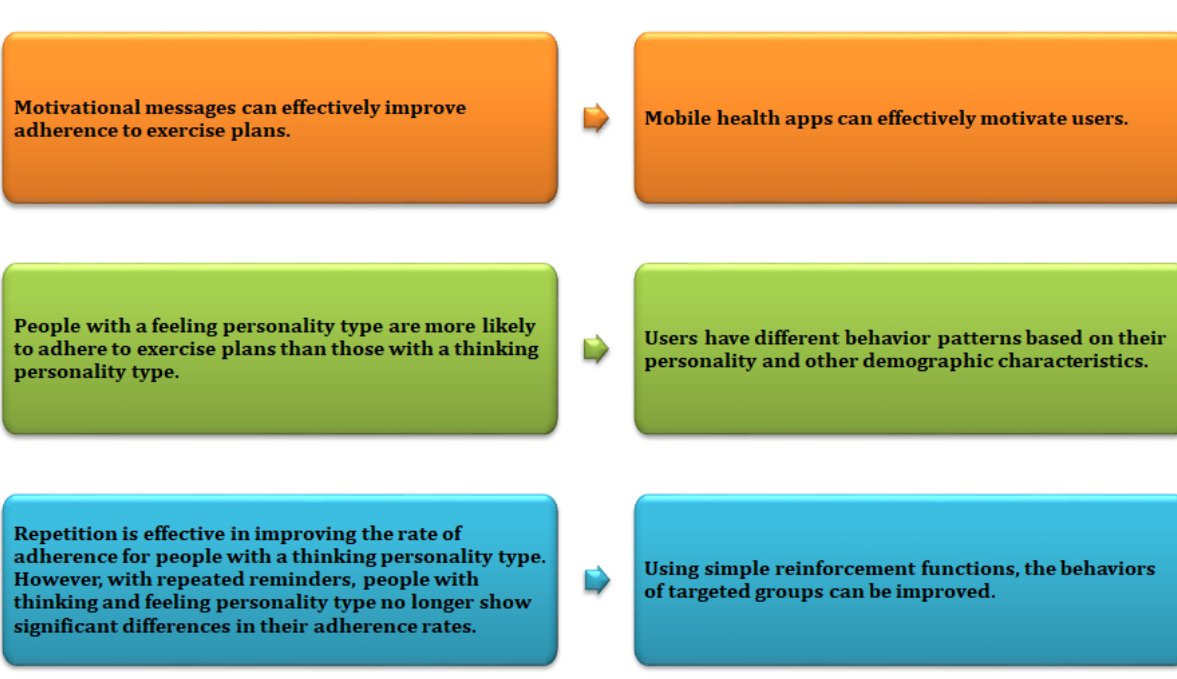
Figure 5. Revised design principles and